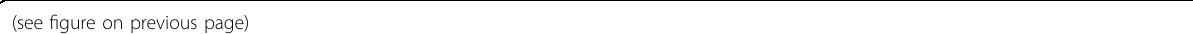
Fig. 6 SChLAP1/EZH2 promote prostate cancer cell proliferation and migration through the miR-340-5p/miR-145-5p-DNMT3a loop. A QPCR analysis for the expression of SChLAP1, miR-340-5p, miR-143-3p, miR-145-5p, and DNMT3a mRNA in DU145 and LNcap cells with SChLAP1 silencing combined with DNMT3a expression or not. B Western blotting analysis for the DNMT3a protein level in DU145 and LNcap cells with SChLAP1 silencing combined with DNMT3a overexpression or not. C Colony-formation assay for cell proliferative capacity of DU145 and LNcap cells with SChLAP1 silencing combined with DNMT3a overexpression or not. D Transwell assay for cell migration capacity of DU145 and LNcap cells with SChLAP1 silencing combined with DNMT3a overexpression or not. The results are presented as the mean ± SD. * P < 0.05, ** P < 0.01, *** P < 0.001. SChLAP1 second chromosome locus associated with prostate-1, EZH2 Enhancer of Zeste Homolog 2, DNMT DNA